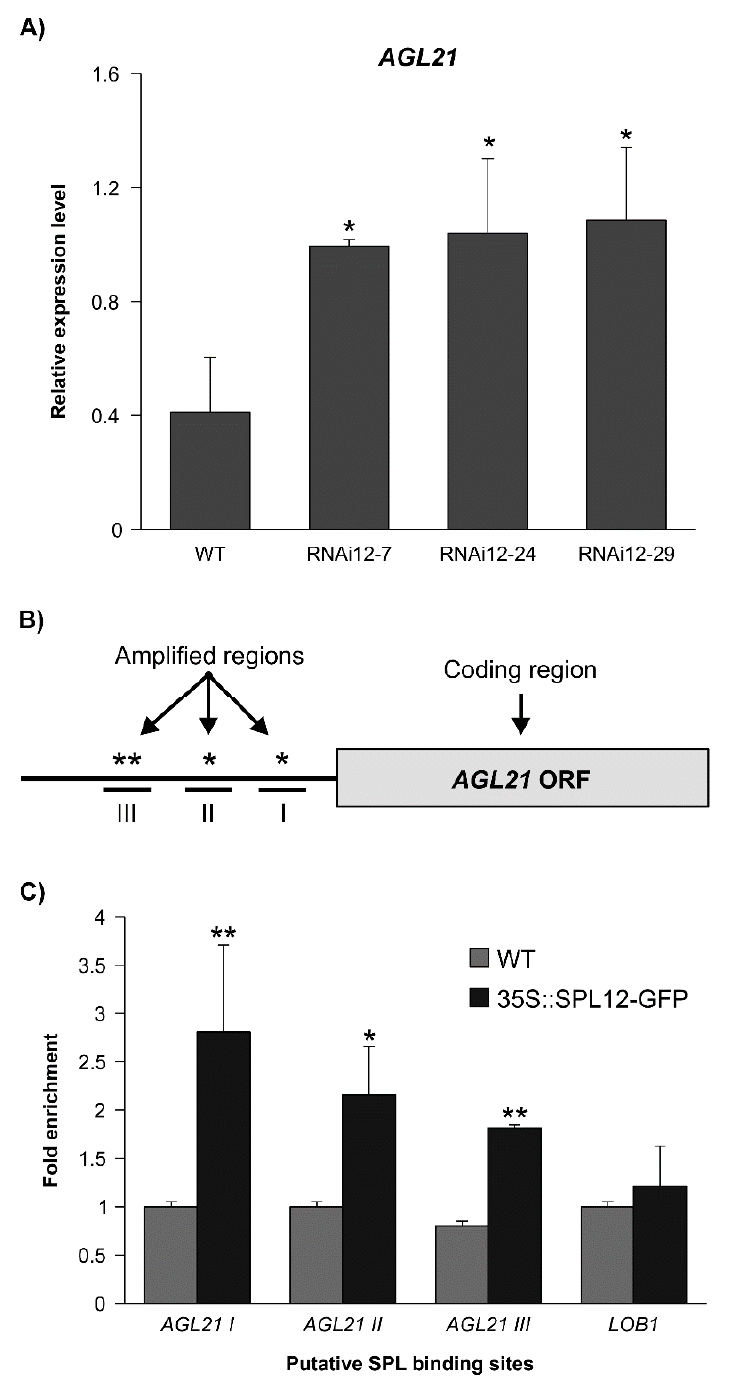
Figure 4. Detection of SPL12 binding to AGL21 promoter ( A ) Relative AGL21 expression in roots of WT and SPL12 -RNAi alfalfa plants by qPCR. ( B ) Schematic representation of the promoter region of AGL21 , black box represents the coding sequences (ORF); asterisks indicate locations of putative SPL binding sites on AGL21 promoter (amplified regions). Roman numerals (I, II and III) indicate the sites that were tested by qPCR. ( C ) ChIP-qPCR-based fold-enrichment analysis of SPL12 in 35S::SPL12m-GFP and WT plants from means of n = three individual plants where LATERAL ORGAN BOUNDARES-1, LOB1 , is used as a negative control. * and ** indicate significant differences relative to WT using Student’s t -test (n = 3) p < 0.05, p < 0.01, respectively. Error bar indicates standard